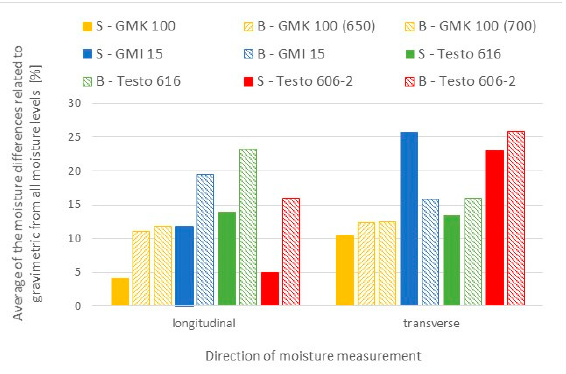
Figure 10. Comparison of the mean percentage differences in measured MC values compared to gravimetric values for all the selected moisture levels from 5% to 30%.